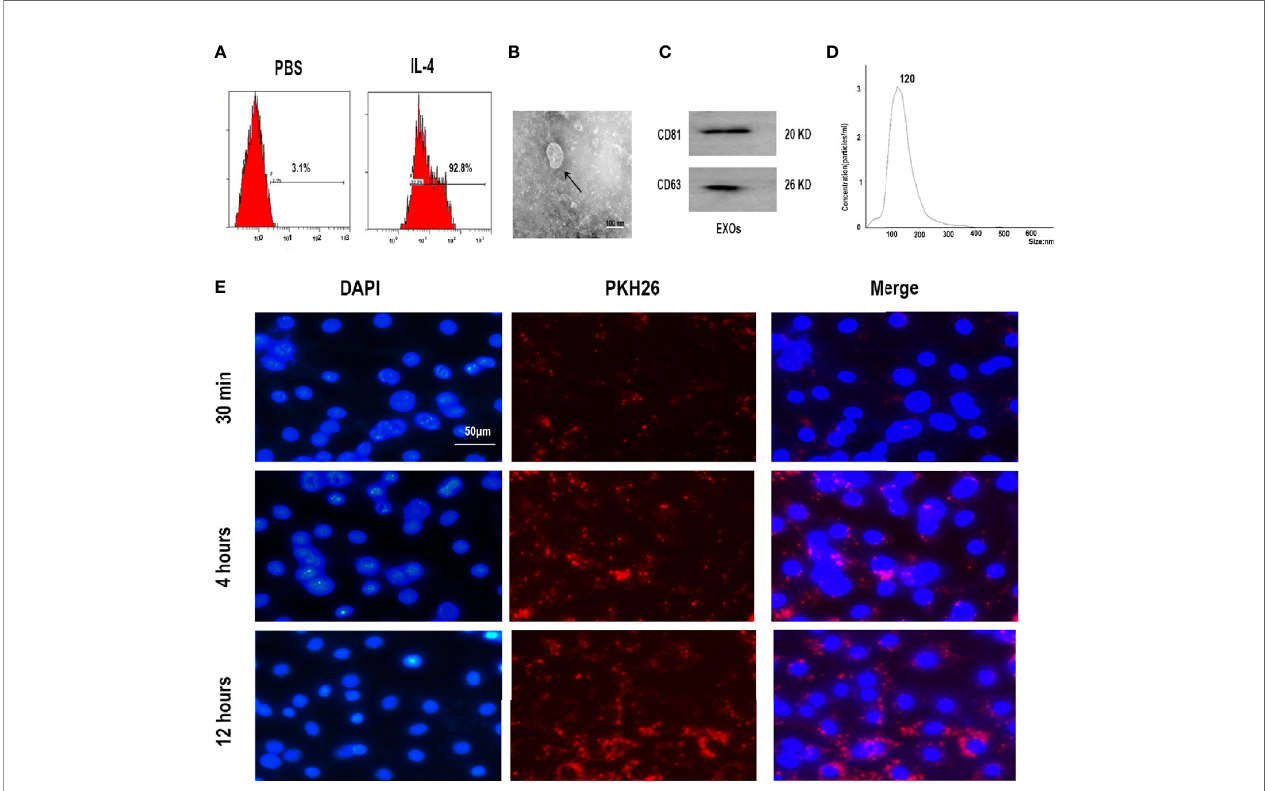
FIGURE 1 | Characterization of M2 macrophages and exosomes derived from M2 macrophages. (A) Expression of M2 marker CD206 in polarized RAW 264.7 cells analyzed by fl ow cytometry. (B) Morphology identi fi ed by TEM, scale bar:100 nm. (C) The surface biomarkers CD63, CD81 were analyzed by Western blotting assay. (D) Size distribution pro fi les of M2D-Exos was detected by nanoparticle tracking analysis. (E) The exosomes derived from M2 macrophages was marked with red fl uorescence dye PKH26 and co-cultured with BMSCs, scar bar = 50